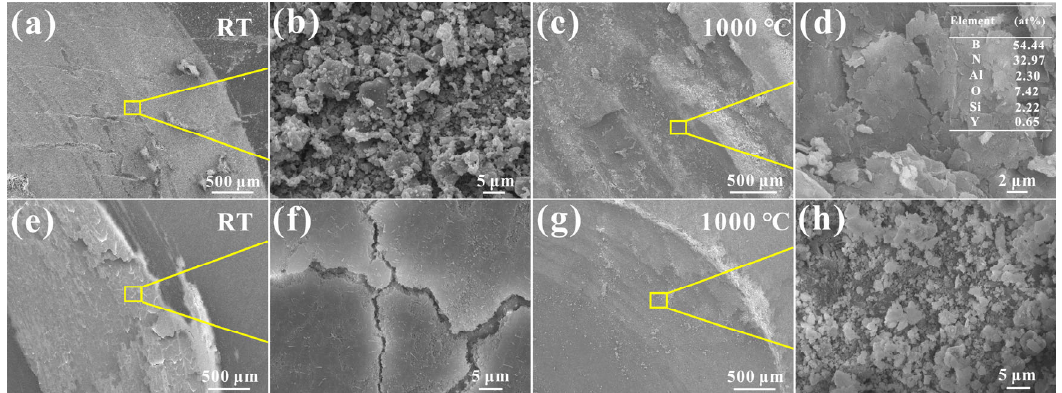
Fig. 11 SEM morphologies of the worn surfaces of (a–d) PcBN/hBN fibrous monolithic ceramics and (e–h) homogenous PcBN composites at different test